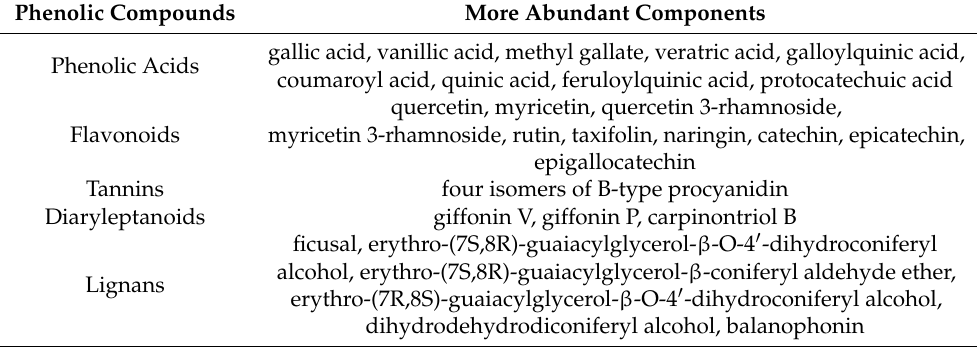
Table 1. Phenolic compounds in hazelnut